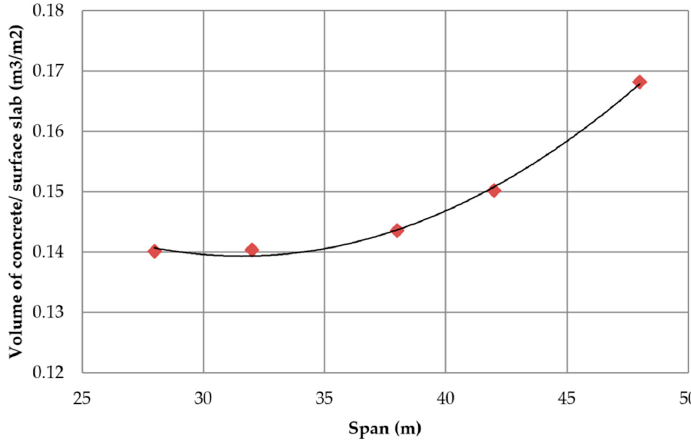
Figure 12. Variation in the ratio of the rolled steel amount in relation to the surface of the slab with the span.